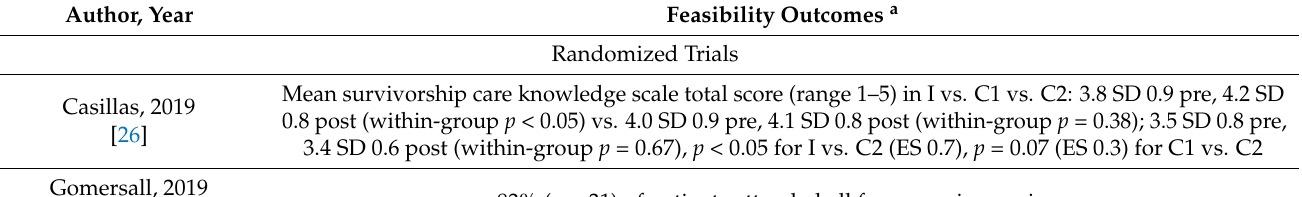
Table 4. Feasibility and implementation outcomes ( n = 16